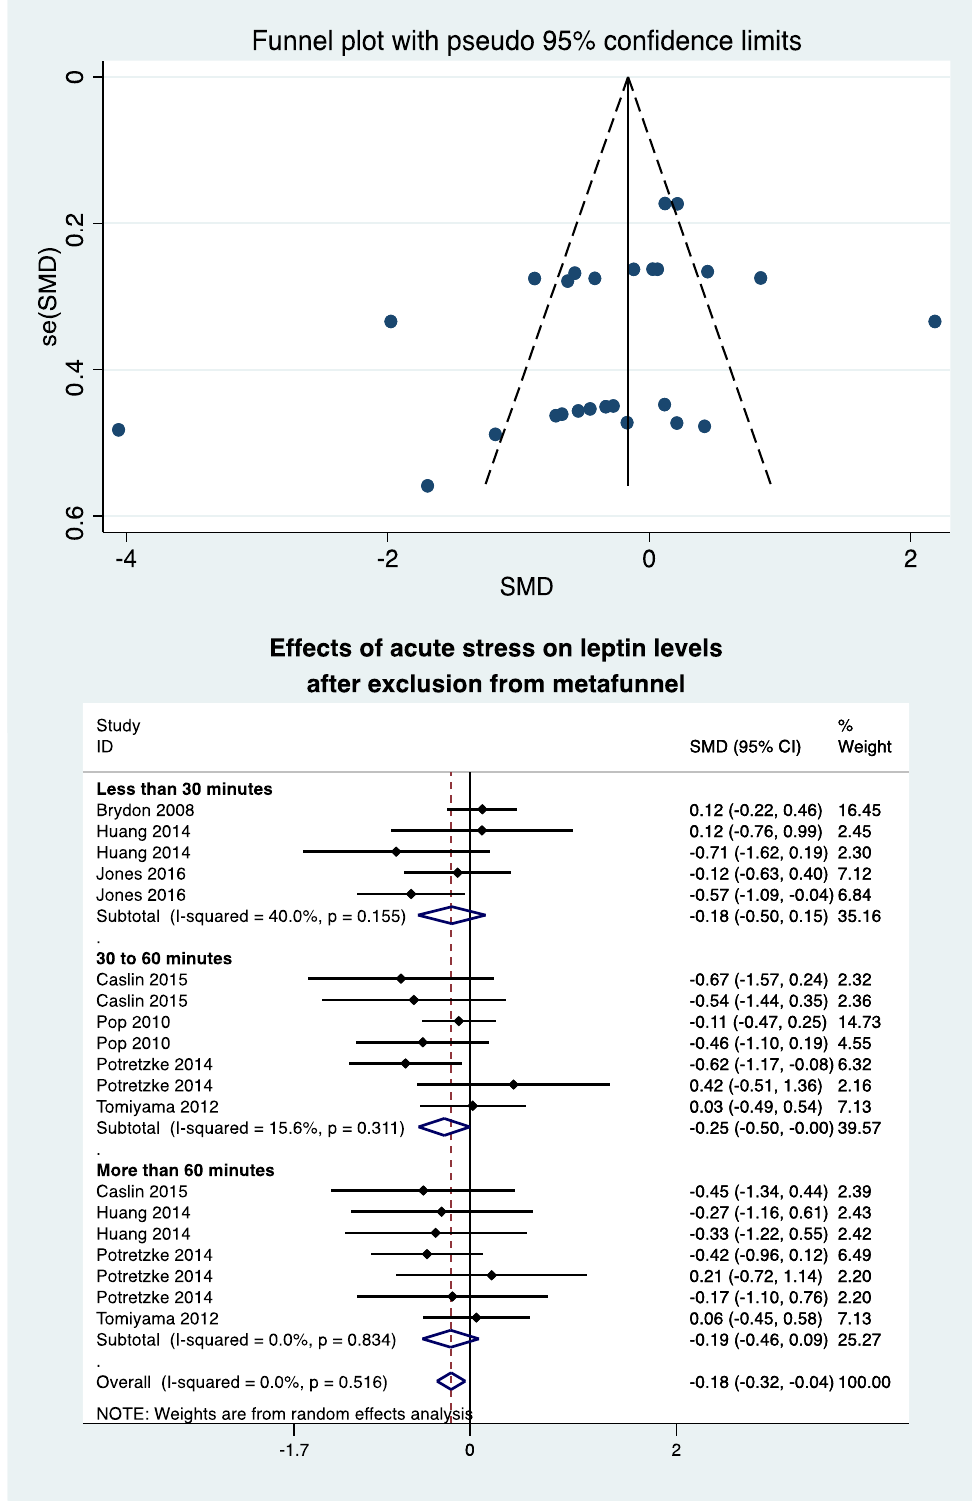
Figure 5. Meta-analysis of leptin levels after acute stress compared to baseline levels after exclusion of studies outside of the metafunnel. SMD, standardized mean difference.